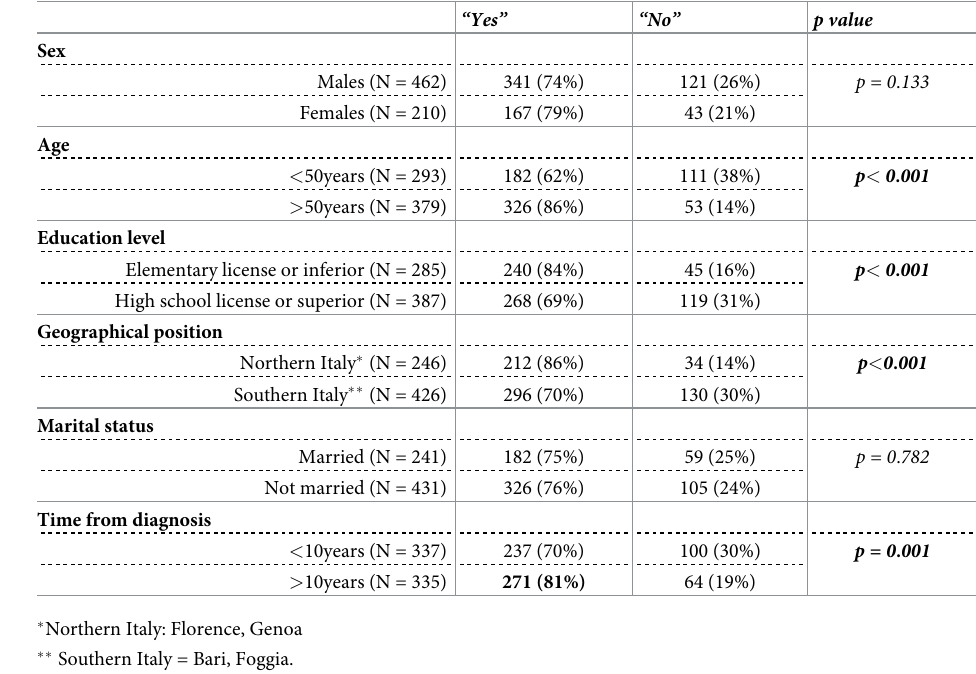
Table 2. Communication of HIV positivity to GPs according to socio-demographic features.